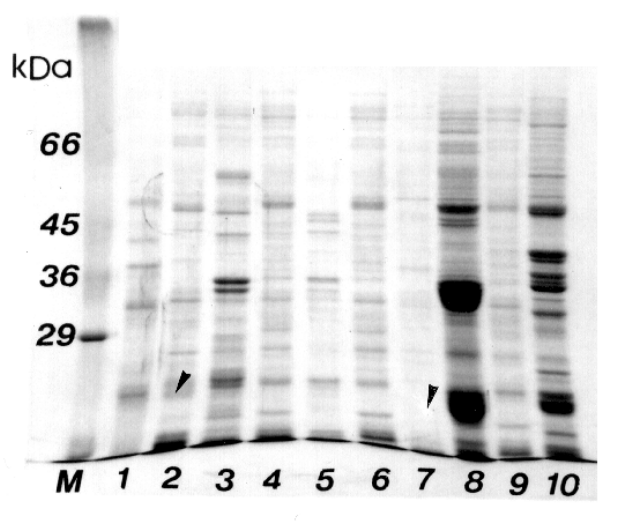
FIGURE 1. SDS-PAGE electrophoretogram of seed proteins of different species of buckwheat. Lane 1: F. esculentum ; Lane 2: F . gracilipes ; Lane 3: F . callianthum ; Lane 4: F . statice ; Lane 5: F . rubufobium ; Lane 6: F . macrocarpum ; Lane 7: F . lineare ; Lane 8: F . cymosum ; Lane 9: F . pleioramasum; and Lane 10: F . esculentum ancestralis . The arrowheads indicate the position of the 22-kDa protein